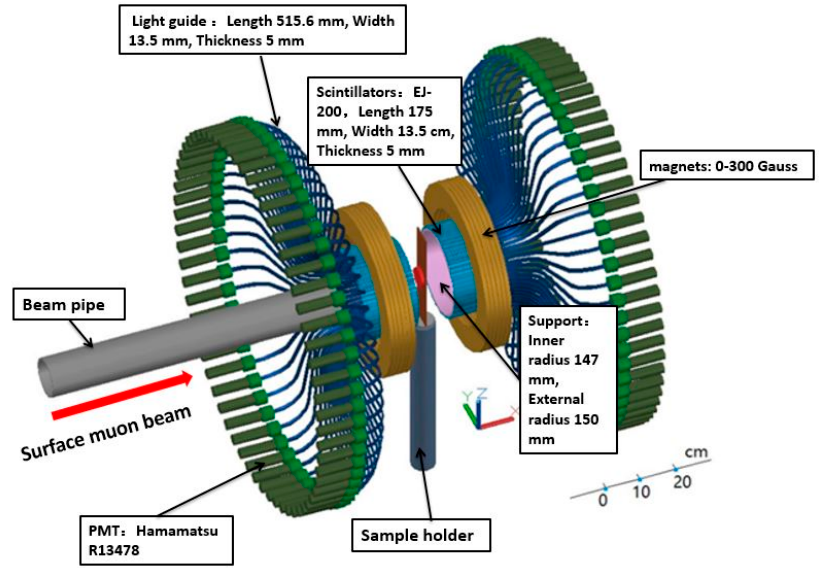
µ SR spectrometer